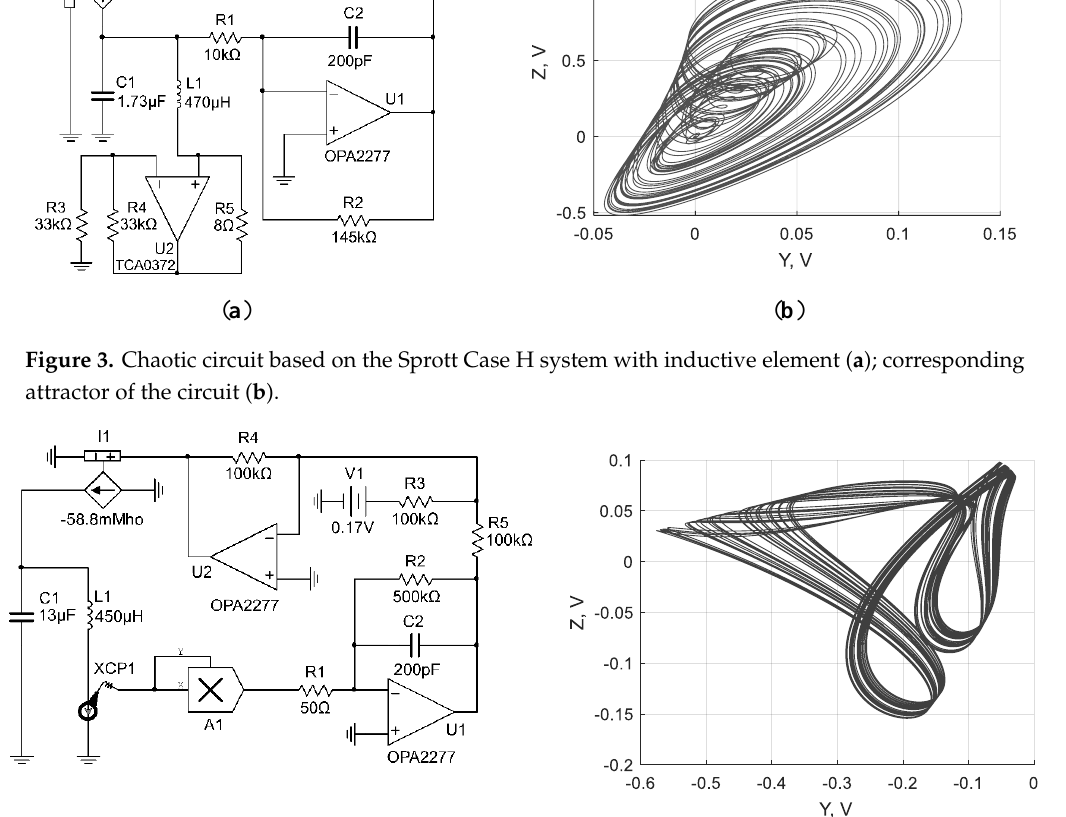
Figure 4. Chaotic circuit based on the Sprott Case M system with inductive element ( a ); corresponding attractor for the circuit ( b ).